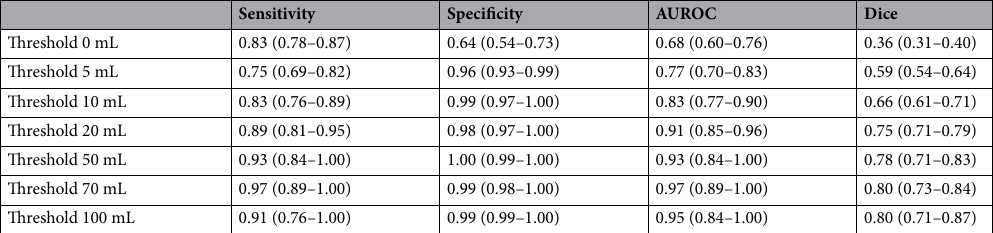
Table 3. Sensitivity, specificity, AUROC, and Dice values for the full, heterogeneous test set including both MCA and non-MCA territory infarcts (n = 364 patients, Table 1), at the 0 mL, 5 mL, 10 mL, 20 mL, 50 mL, 70 mL, and 100 mL volume thresholds for